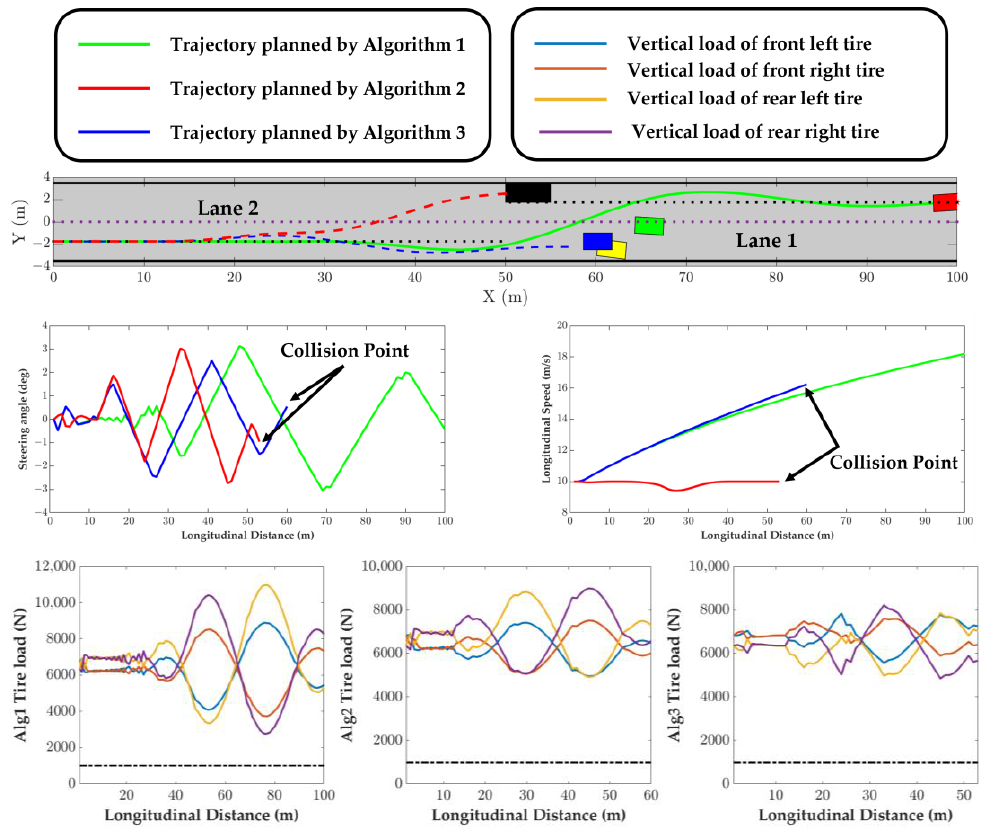
Figure 8. The sketch of the scenario in Experiment 4.